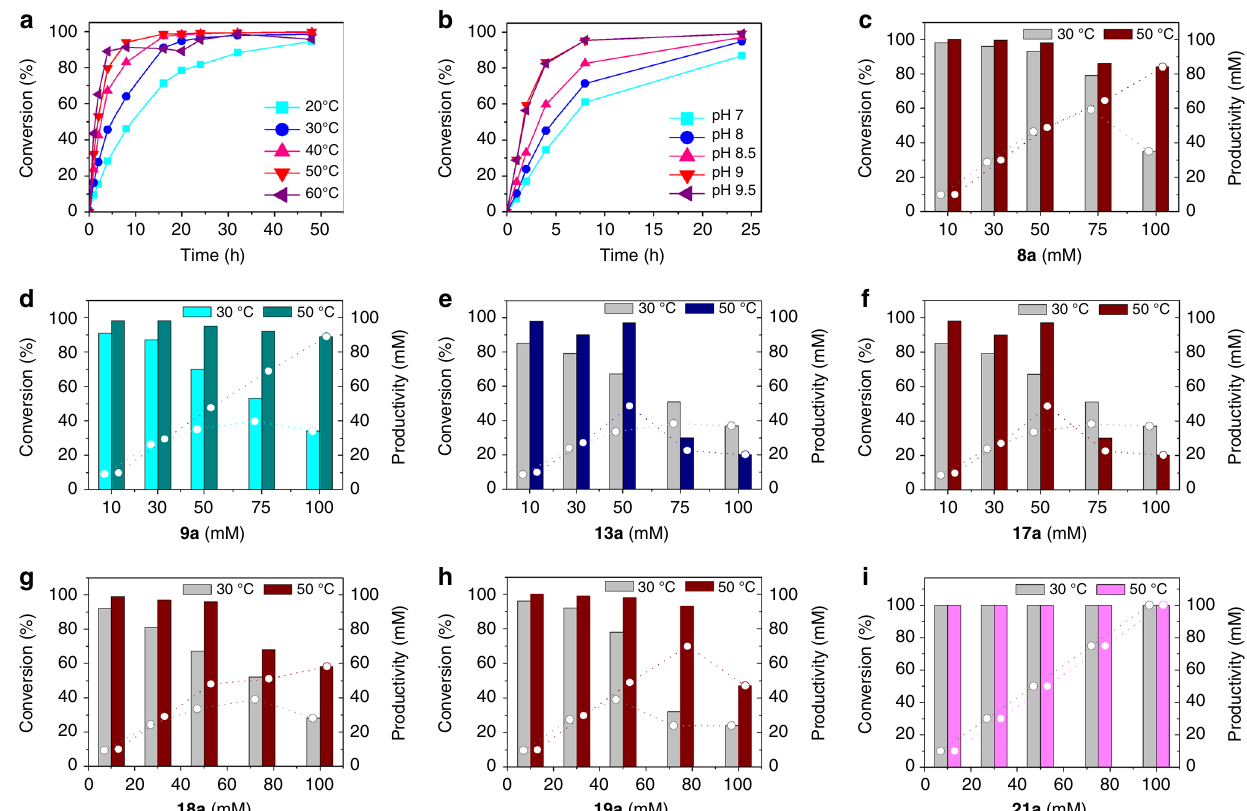
Fig. 3 Optimisation studies employing LE-AmDH-v1. Reaction conditions: 0.5 mL fi nal volume; buffer: HCOONH 4 /NH 3 2 M pH 7.0 – 9.5; 170 rpm on orbital shaker; [substrate] = 10 – 100 mM; [NAD + ] = 1 mM; [LE-AmDH-v1] = 90 μ M; [Cb-FDH] = 19 μ M; reaction time: 1 – 48 h ( a – b ) and 48 h ( c – i ) a In fl uence of the temperature (20 to 60 °C) on the reductive amination of 8a in HCOONH 4 /NH 3 2 M pH 9.0 buffer. b In fl uence of the pH values using HCOONH 4 /NH 3 buffer at 50 °C on the reductive amination of 8a. c – i Effect of the substrate concentration on conversions (left y -axis; columns) and productivities (right y - axis; dashed lines with symbols) at two different temperatures: 30 and 50 °C). Source data are provided as a source data fi le. Data are based on